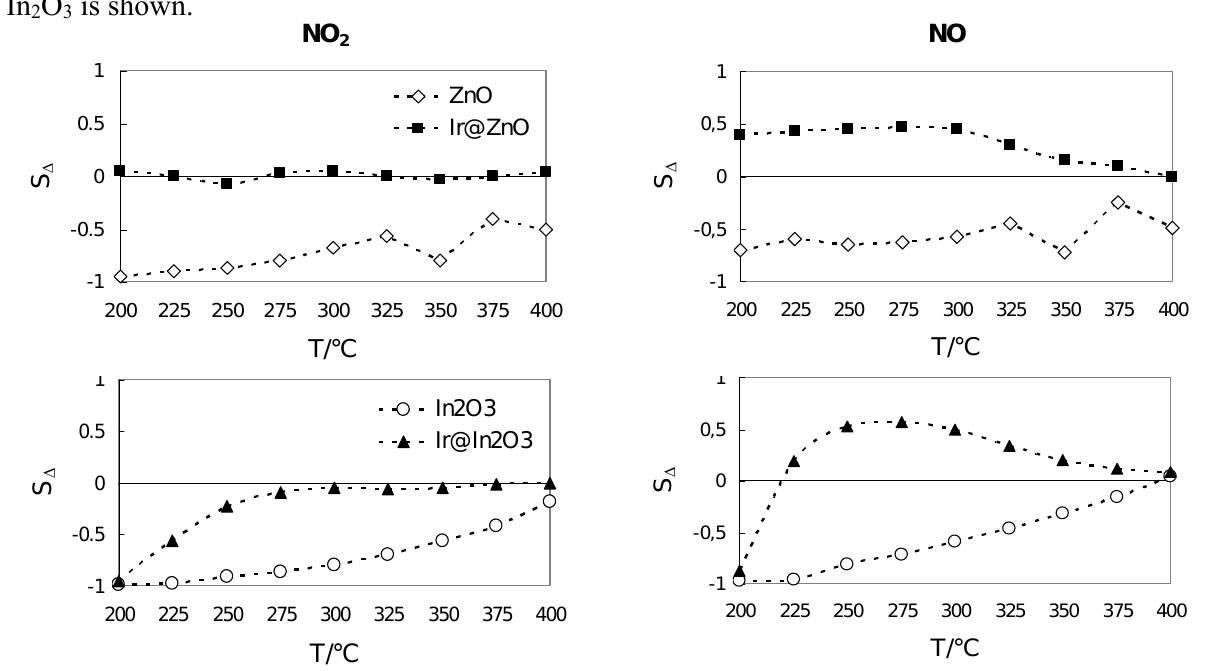
towards NO and NO of both, doped and undoped 2 ∆ of Ir-doped and undoped ∆